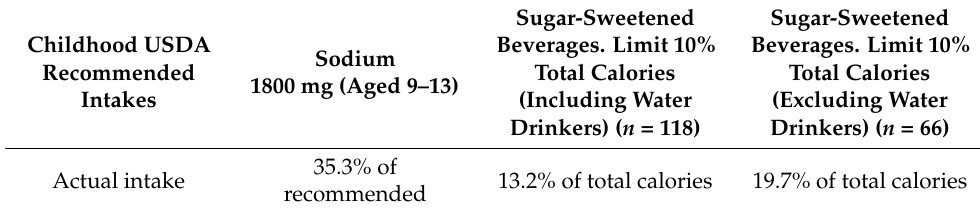
Table 4. Packed school lunches meeting nutrient recommendations ( n =